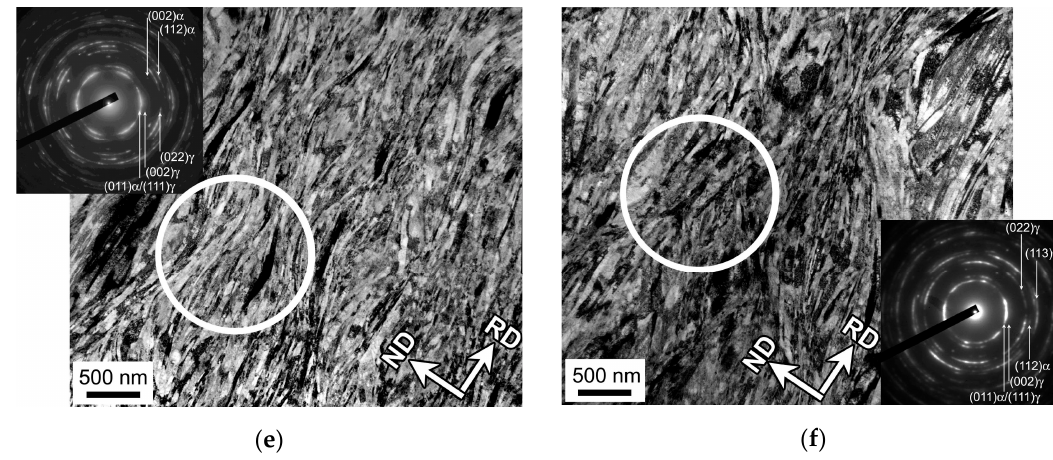
Figure 8. Fine structures in 304L ( a , c , e ) and 316L ( b , d , f ) stainless steels subjected to rolling at 473 K to total strains of 0.5 ( a , b ), 1 ( c ), 2 ( d ) and 3 ( e , f ). The circles indicate the portions for selected area electron diffraction patterns.